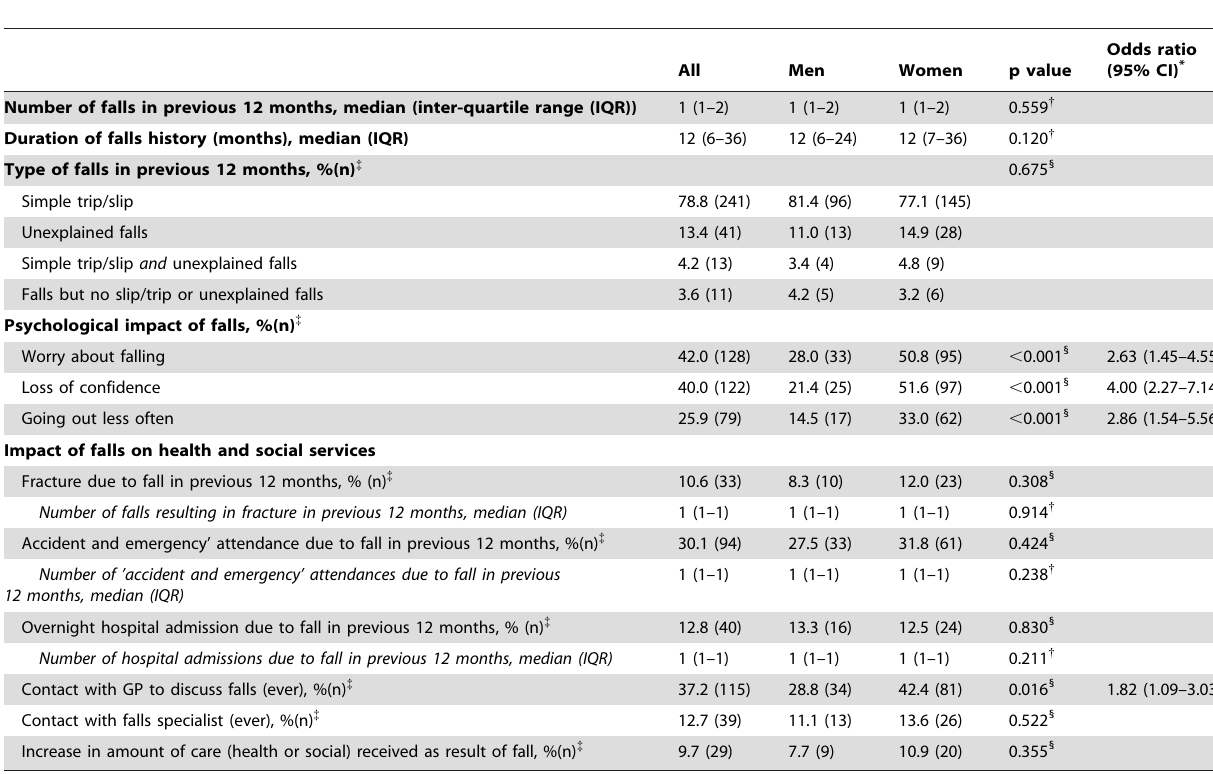
Table 1. Falls: number, duration of history, sub-types, psychological impact and impact on health and social care services - reported for those who had fallen in the previous 12 months, by gender.